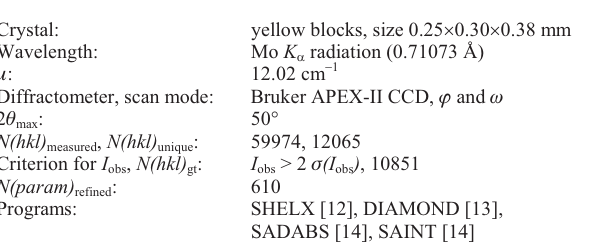
Table 1. Data collection and handling.